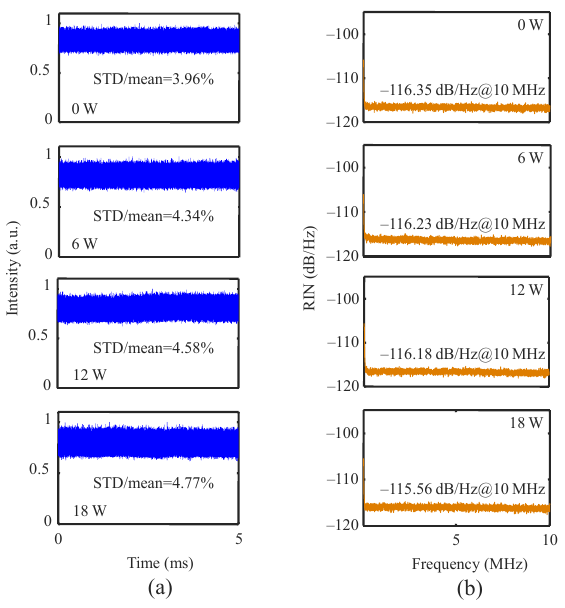
Fig. 4 Temporal properties of the amplified YRFL pumps with different LD powers: (a) time domain traces and (b)